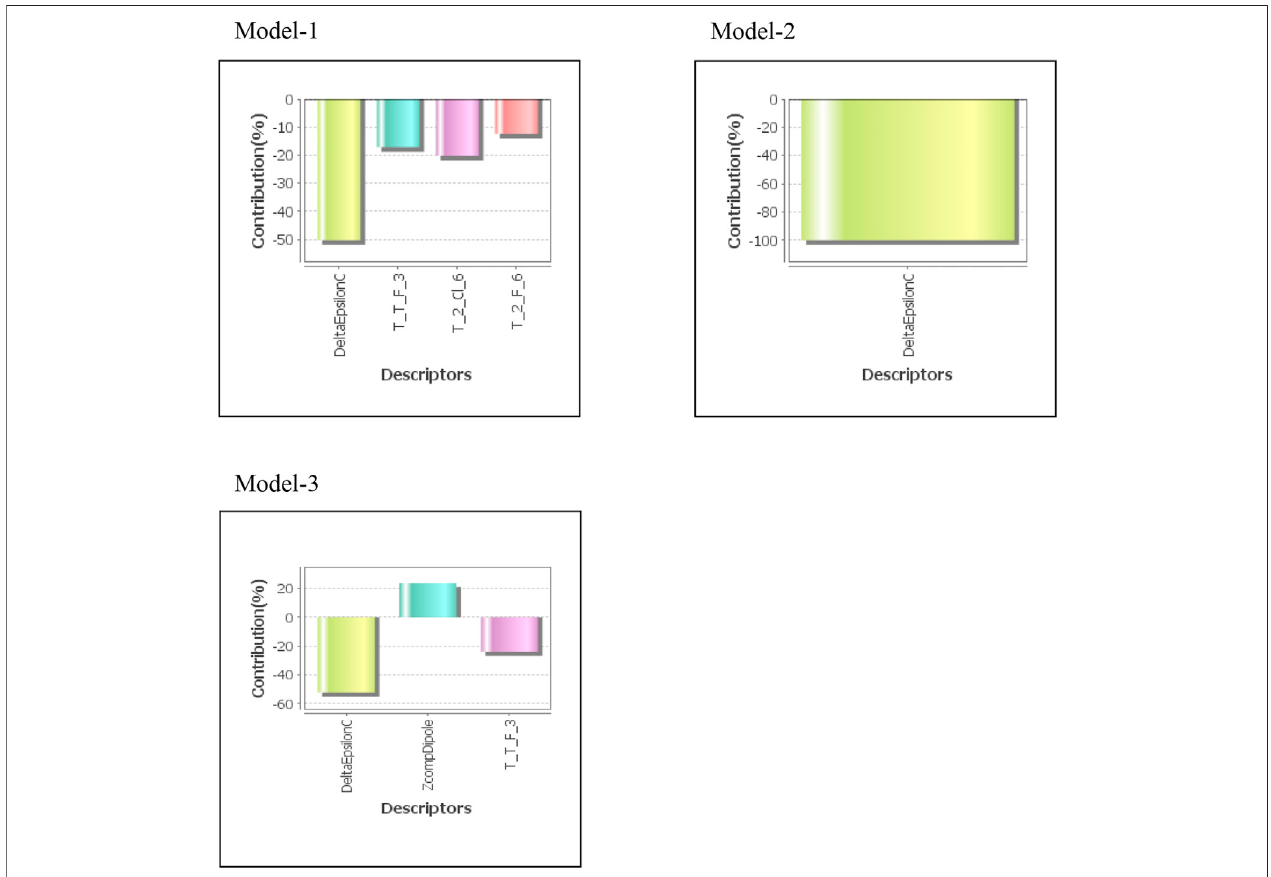
FIGURE 2 | Contribution charts of the 2D-QSAR